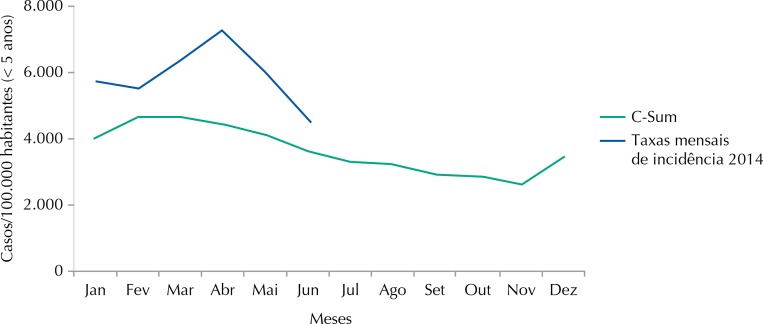
Canal endêmico 2009-2013 (crianças menores de 5 anos) pelo método C-Sum e taxas de incidência mensais registadas em 2014 (crianças menores de 5 anos), Moçambique.